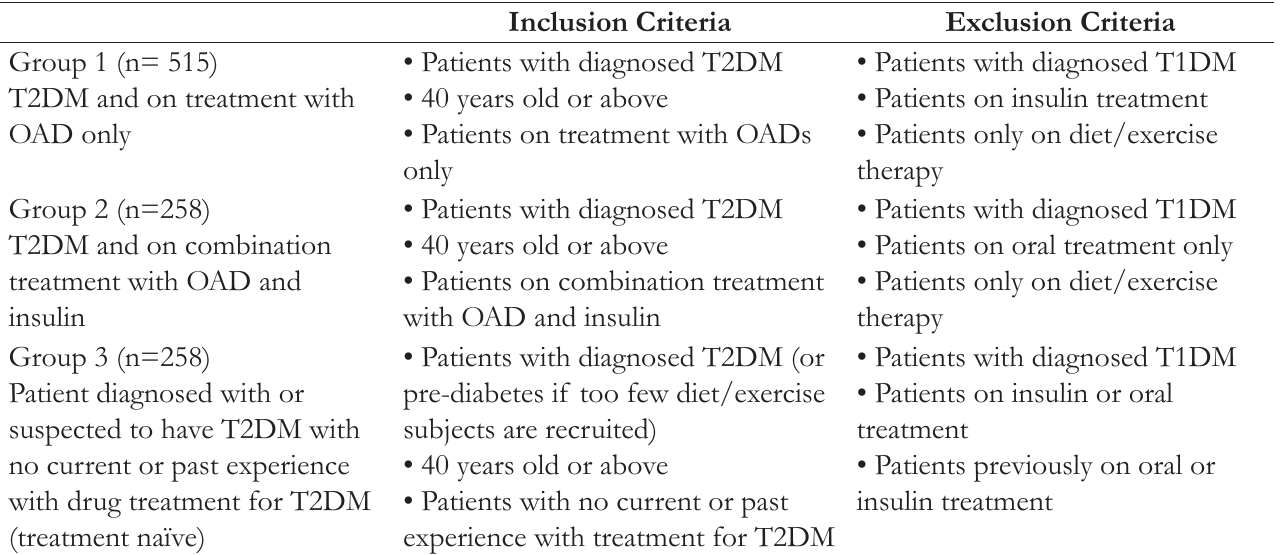
Table 1. Inclusion and Exclusion Criteria Inclusion Criteria Exclusion